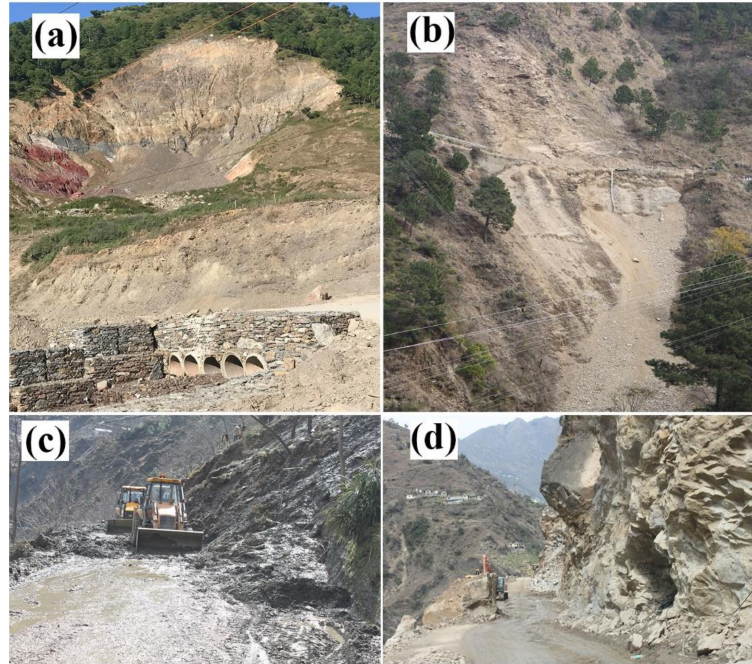
Figure 11. Landslides: ( a ) Kotpuri of Mandi districts, a massive landslide occurred on 13 August 2017, 46 people died, that we visited during the primary survey; ( b ) huge landslide blocked the road for 2 days in Chamba districts; ( c ) on our way to Bharmour in October 2019, a landslide blocked the road for one week; ( d ) landslide near Bhaba Nagar of the Kinnaur districts within the Satluj basin. All the photographs were taken during our primary